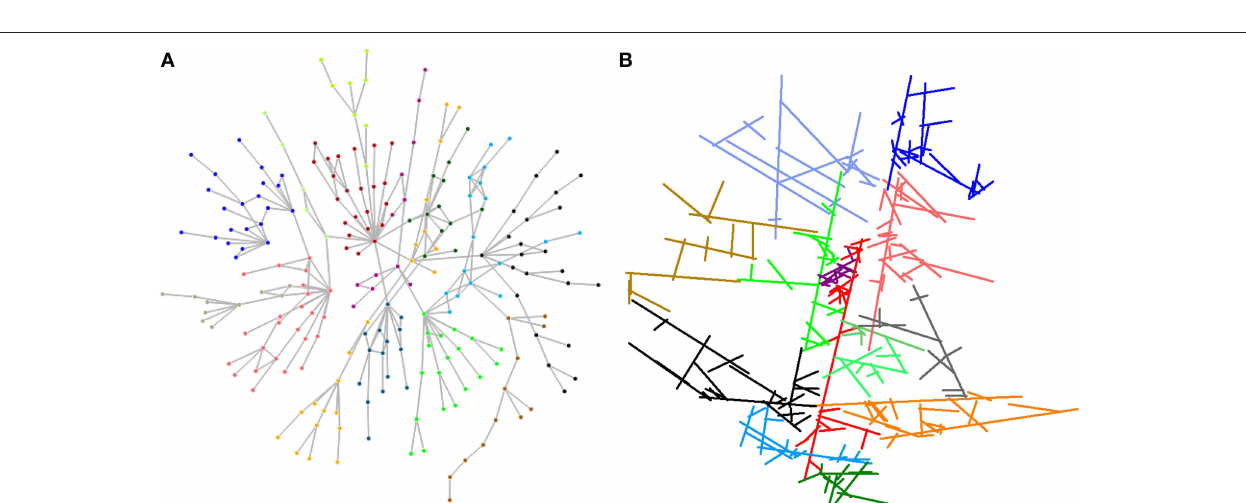
FIGURE 7 | (A) Community structure of the largest component ( r = 0 . 12 ) of a sample of the Poissonian DFN model shows seven distinct groups. (B) Community structure of the largest component ( r = − 0 . 18 ) of a sample of the mechanical DFN model shows 20 distinct groups. The different groups or communities are identified by the color of the nodes.